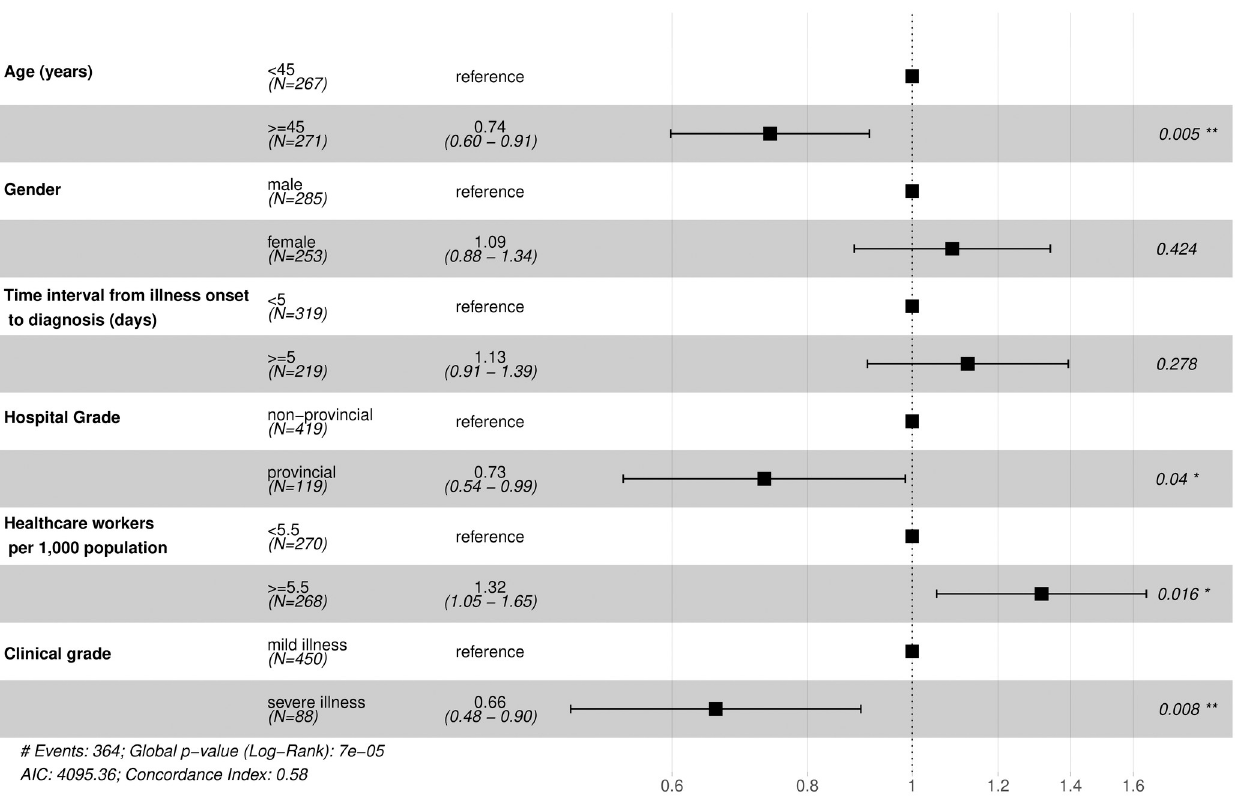
Fig 3. Risk factors for LoS of COVID-19 confirmed